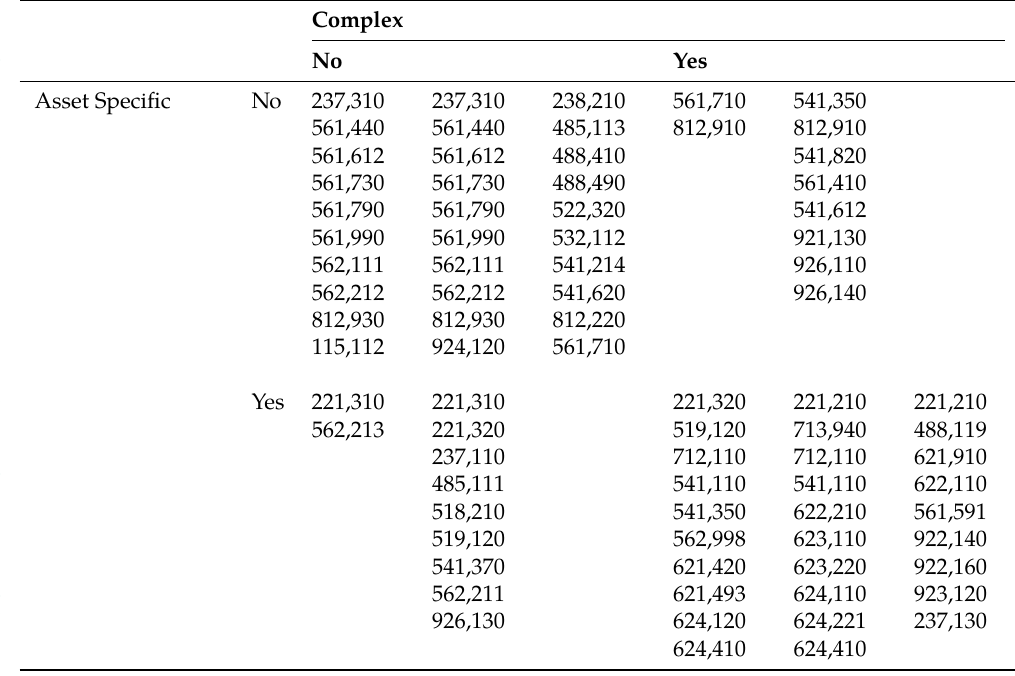
Table 3: Tablulation of NAICS